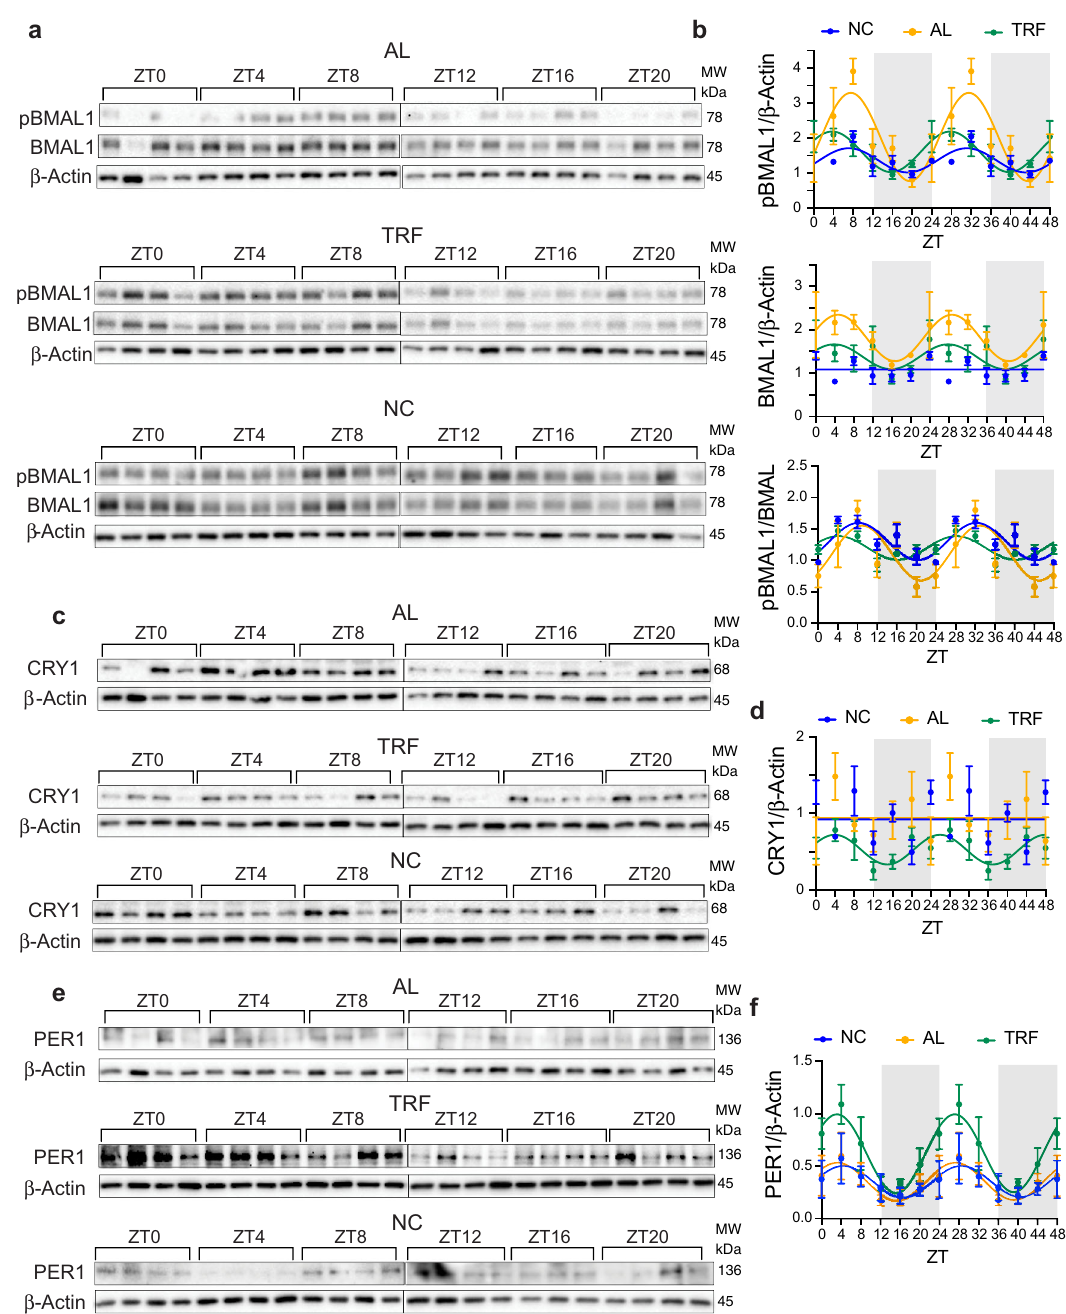
Fig. 9 TRF normalizes protein endogenous circadian rhythms in breast tumors. a Western blot analysis of the clock protein BMAL1 and phospho- BMAL1(Ser42) in tumor samples collected at different time points (ZT0, 4, 8, 12, 16, 20) over a 24 h period in mice on ad libitum HFD (AL — orange), time-restricted HFD (TRF — green), or chow diet (NC — blue). ZT0 indicates 6 am and the start of the light phase. b Quanti fi cation of the normalized phospho-BMAL1(Ser42), total BMAL1, and the phospho-BMAL1/BMAL1 ratio is graphed over 48 h to facilitate visualization of rhythms ( n = 4 mice/ time/group). Gray rectangles indicate period of lights off. c Western blot analysis of the protein CRY1 in tumor samples collected at different time points (ZT0, 4, 8, 12, 16, 20) over a 24 h period in mice on ad libitum HFD, TRF or NC. d Quanti fi cation of the normalized CRY1 protein expression ( n = 4 mice/time/group). e Western blot analysis of the clock protein PER1 in tumor samples collected at different time points over a 24 h period in mice on ad libitum HFD, TRF, or NC. f Quanti fi cation of the normalized PER1 protein expression ( n = 4 mice/time/group). Data are presented as mean ± SEM normalized to β -actin. Twenty-four hour rhythms were analyzed statistically using RAIN with a period of 24 ±4 h, and circadian curves fi tted using PRISM using the equation Y = baseline + amplitude*cos(frequency*X + phaseshift) using a frequency of 0.2618 for a 24 h period. Proteins with statistically signi fi cant circadian rhythms are shown as curves, acyclic proteins are shown as horizontal lines. Statistical data and circadian parameters are given in Supplementary Table